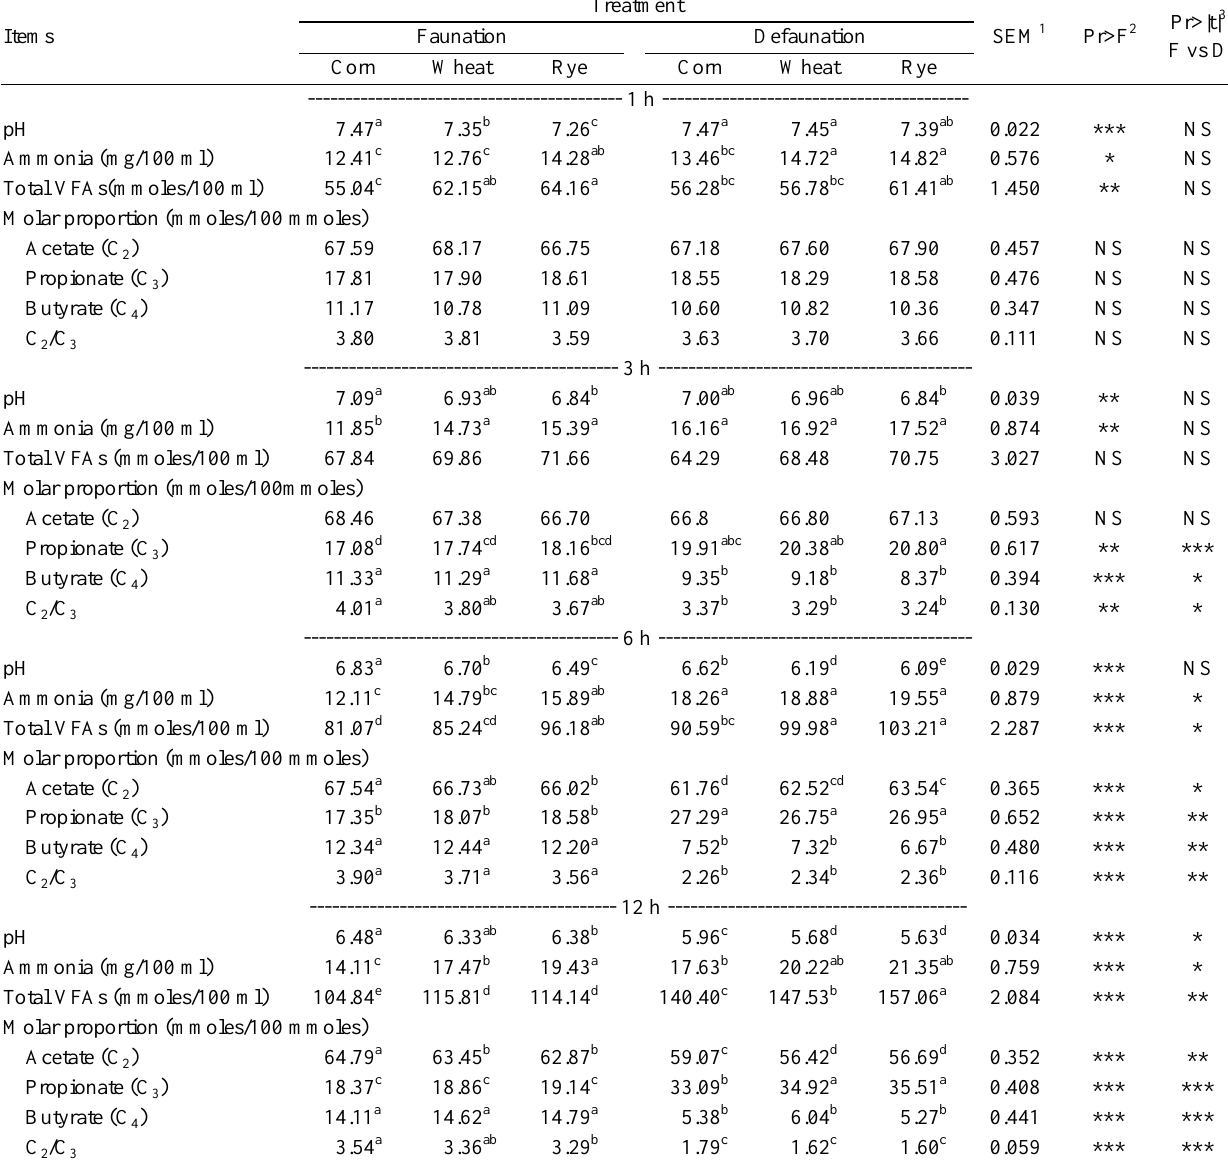
Table 2. pH, ammonia-N concentration and concentration and proportions of major VFAs in the culture solution as influenced by faunation or defaunation when incubated with different cereal grains